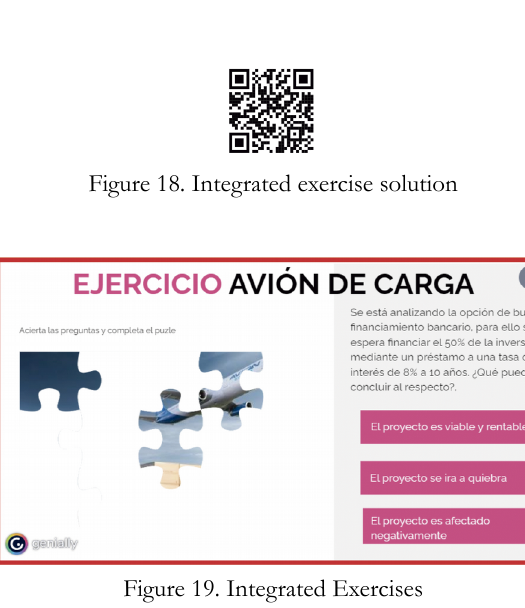
Figure 19. Integrated